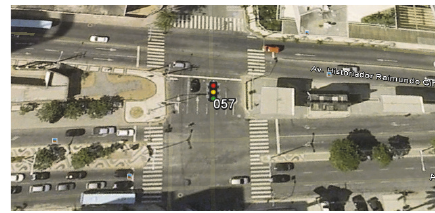
Figure 2: Example atypical intersection removed from the